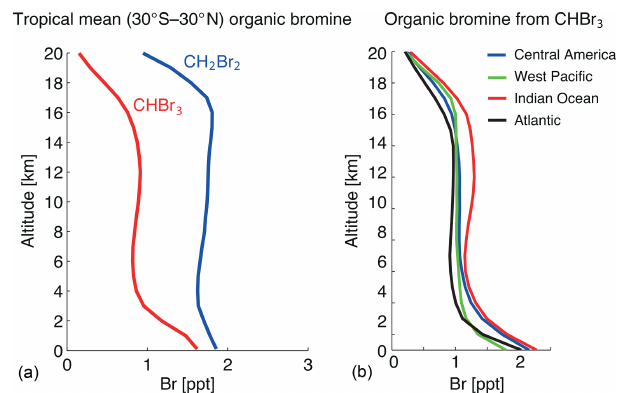
Figure 12. Modelled vertical profiles of CHBr 3 and CH 2 Br 2 (pptBr) in the tropics (30 ◦ S–30 ◦ N) (a) and of CHBr 3 for Central America (0–20 ◦ N, 70–110 ◦ W), west Pacific (15 ◦ S–5 ◦ N, 140 ◦